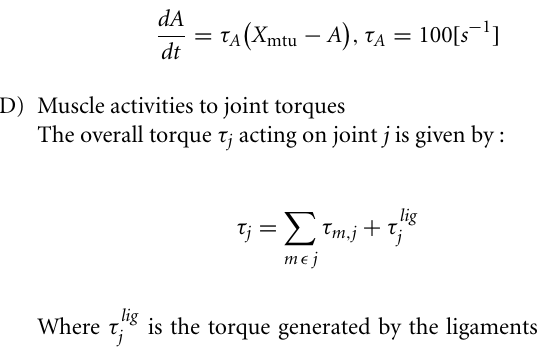
Table 2 | List of the seven different muscles used in the FBL and derived models: GLU for gluteus, HF for hip flexor, VAS for vasilus, GAS for gastrocnemius, TA for tibialis, HAM for hamstring and SOL for soleus.